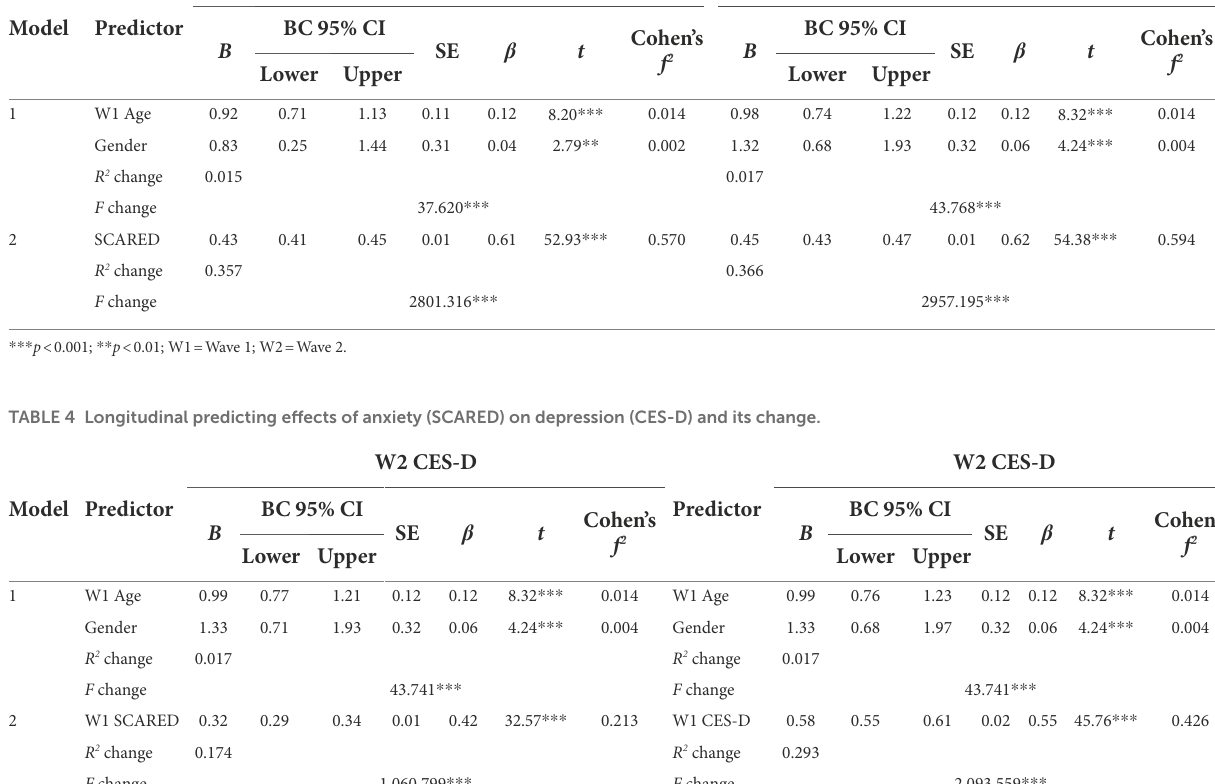
TABLE 3 Cross sectional predicting effects of anxiety (SCARED) on depression (CES-D).